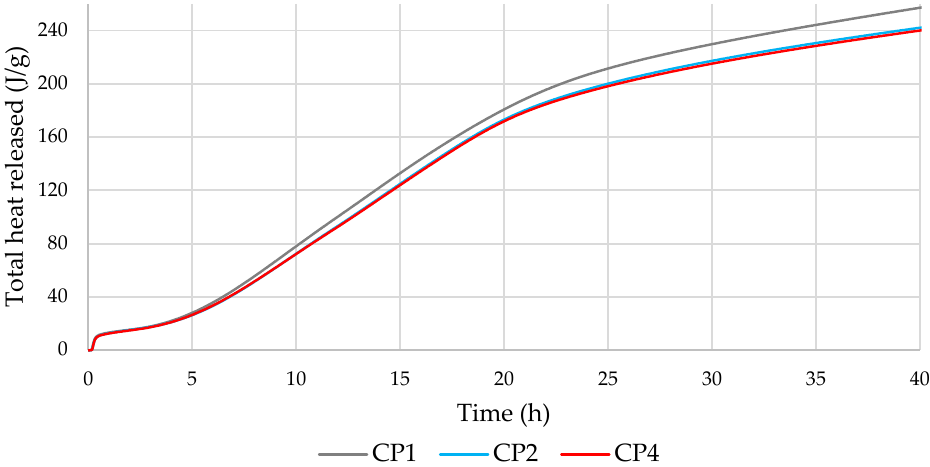
Figure 8. Effect of cement paste composition on the total heat Figure 8. E ff ect of cement paste composition on the total heat released.